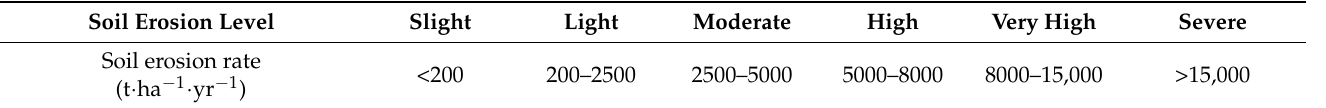
Table 2. The standard for soil erosion